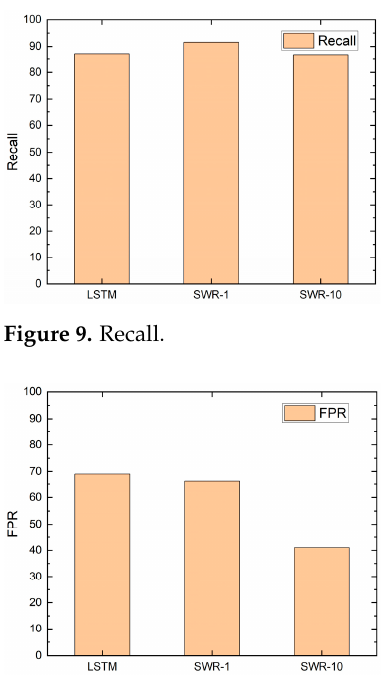
Figure 10. FPR. Figure 10. Figure 10. FPR.